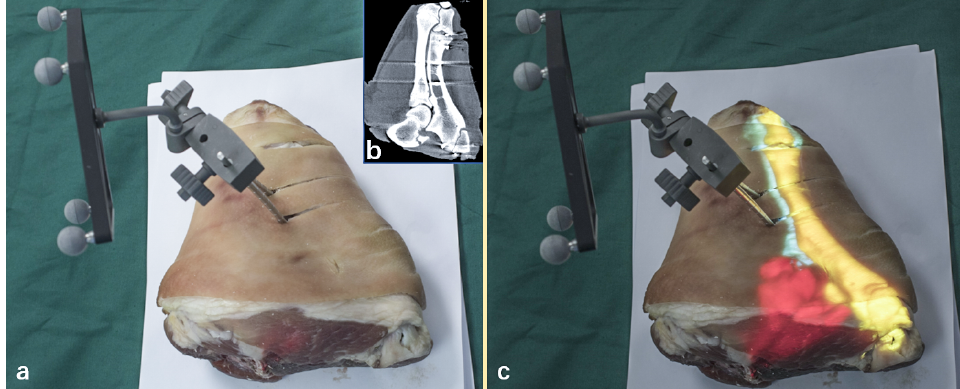
Figure 12. Projection on the in vitro pig leg. ( a ) The original pig leg without projection; ( b ) The CT image indicating the internal bone; ( c ) Project the internal anatomy onto the pig leg.